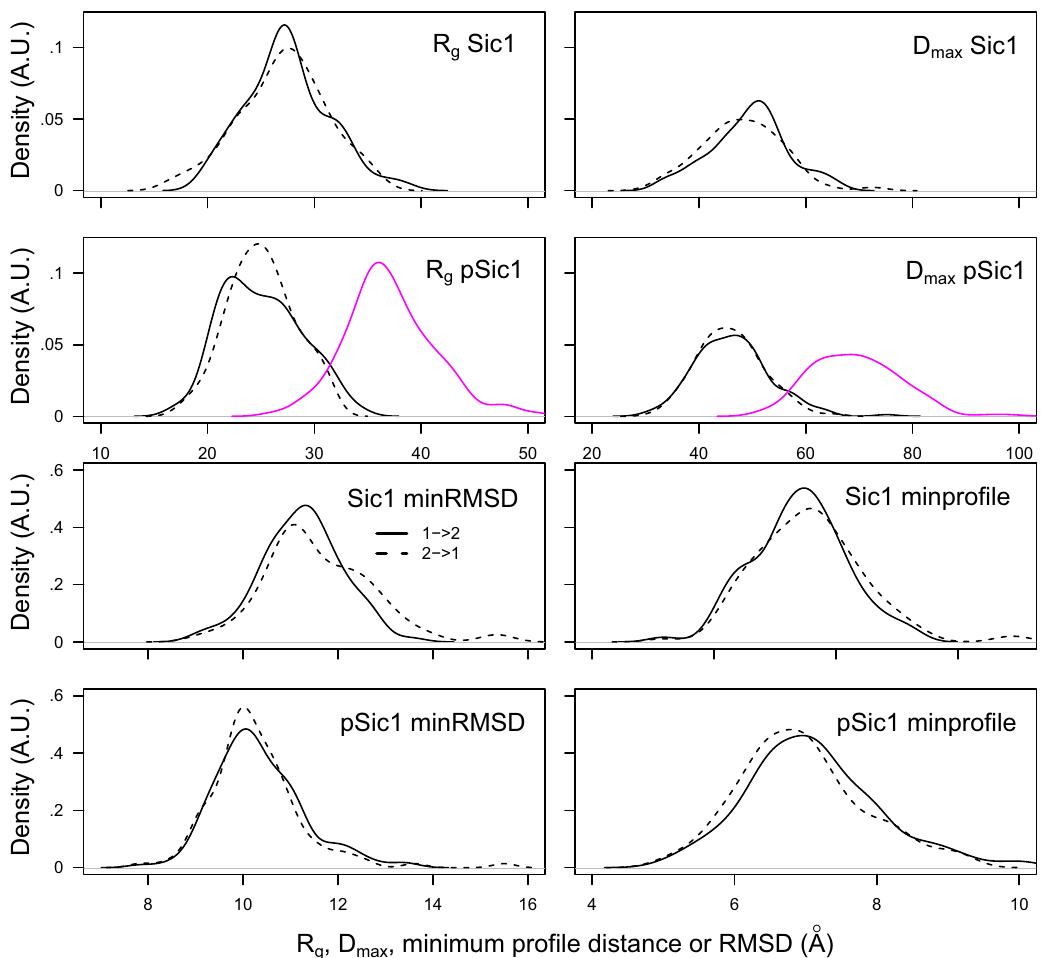
Figure 2. Four panels on top: Distribution of the gyration radii R g and of maximal diameters D max values in the two sets of TAiBP obtained during the first runs Sic1 2 pSic1 (dashed line) runs. The R g and D max distribution obtained for the run pSic1 Four panels on bottom: Distribution of the minimum RMSD values (Å) and of the minimum distances (Å) between profiles for the duplicate runs performed for Sic1 with respect to the second one, dashed line: second run with respect to the first